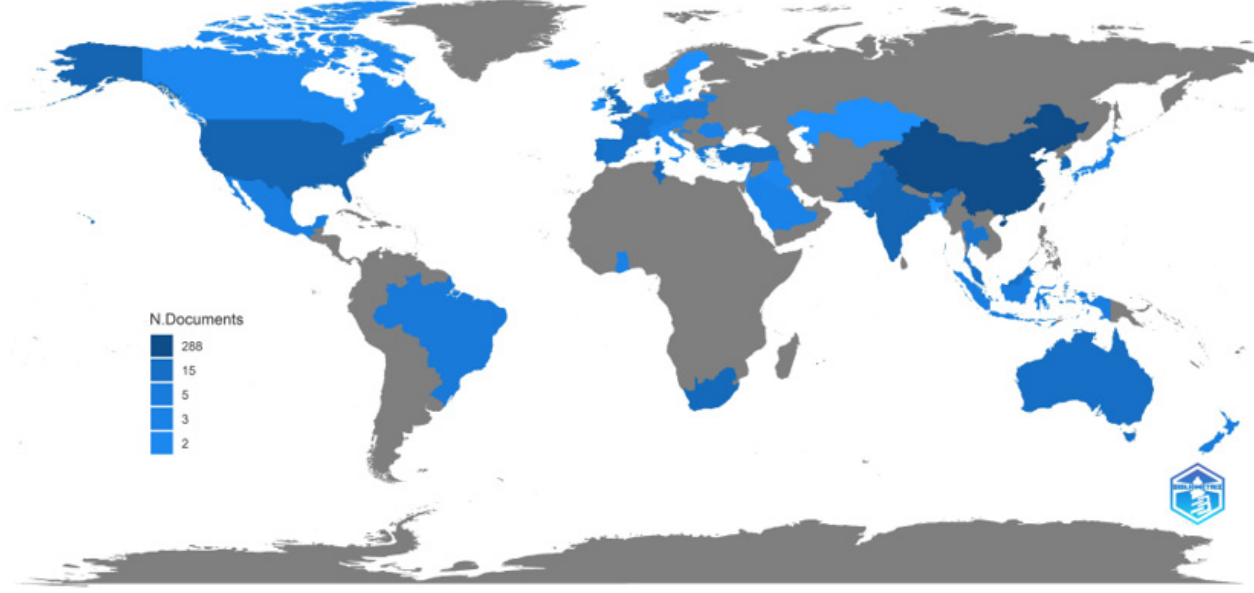
Figure 4. C ountry/territory collaboration map. Figure 4. Country/territory collaboration map.